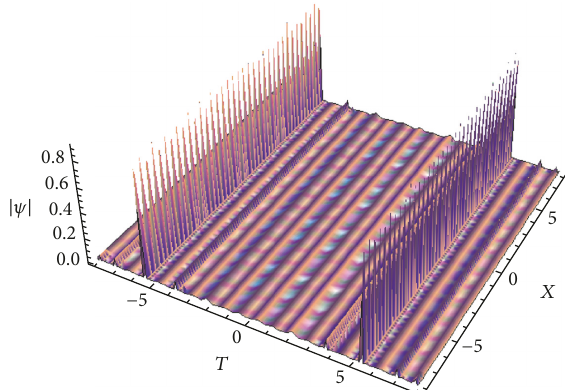
Figure 16: Spatial structure of the module of solution (81) with 𝑘 = 100 .